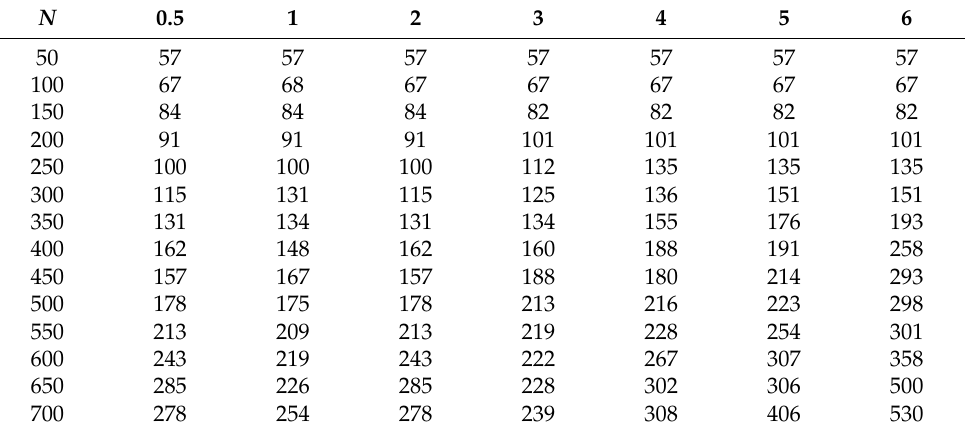
Table 9. The relationship between the number of evacuees and RSET when D max is